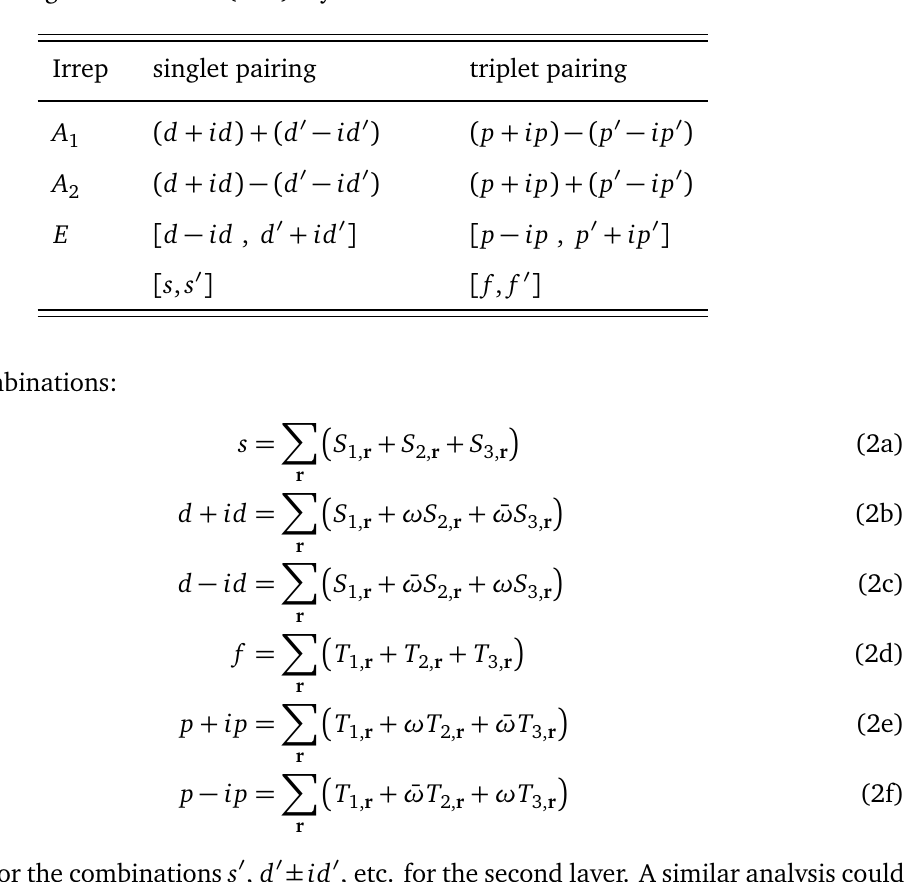
associated with the six pairing 3